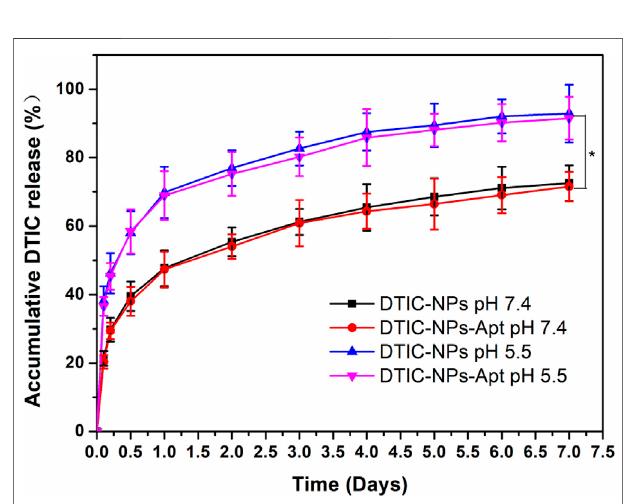
FIGURE5| Invitro drugreleasepro fi lesoftheDTIC-NPsandDTIC-NPs- Apt at pH 5.5 and 7.4, respectively. p p < 0.05.